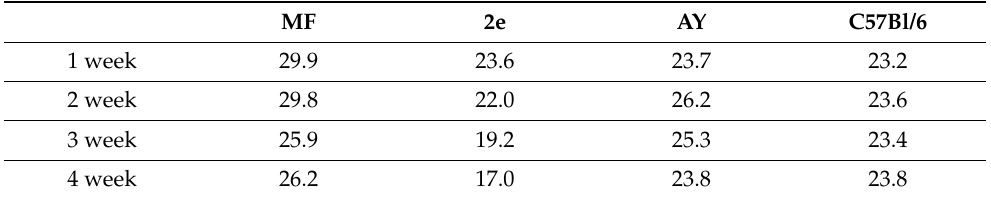
Table 3. Food consumption by mice during the experiment. Data represented as food intake (total amount of standard chow, cookies and lard) in g per a mouse in the